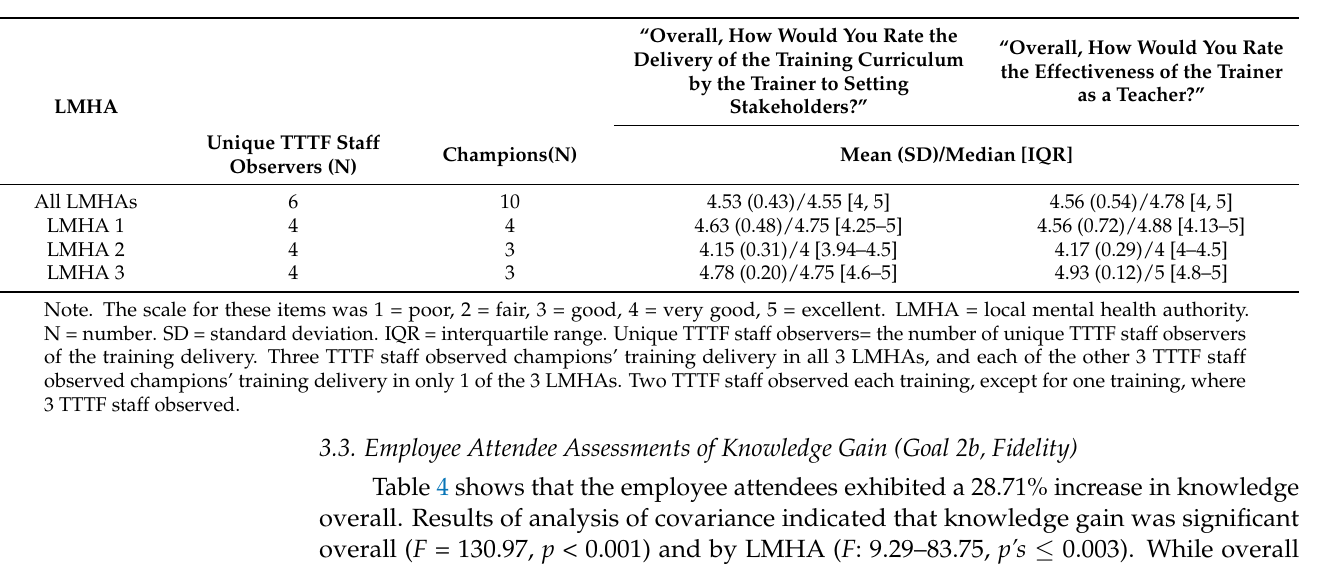
Table 3. TTTF Staff Assessments of Champions’ Tobacco Education Training Delivery to LMHA Employees.